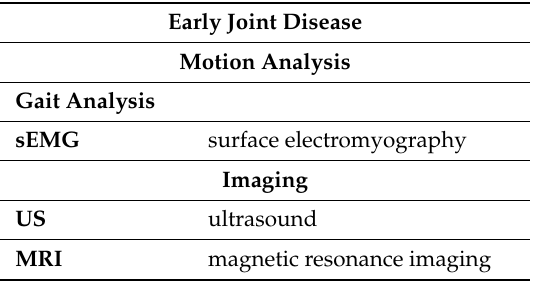
Table 1. Markers related to the early joint disease